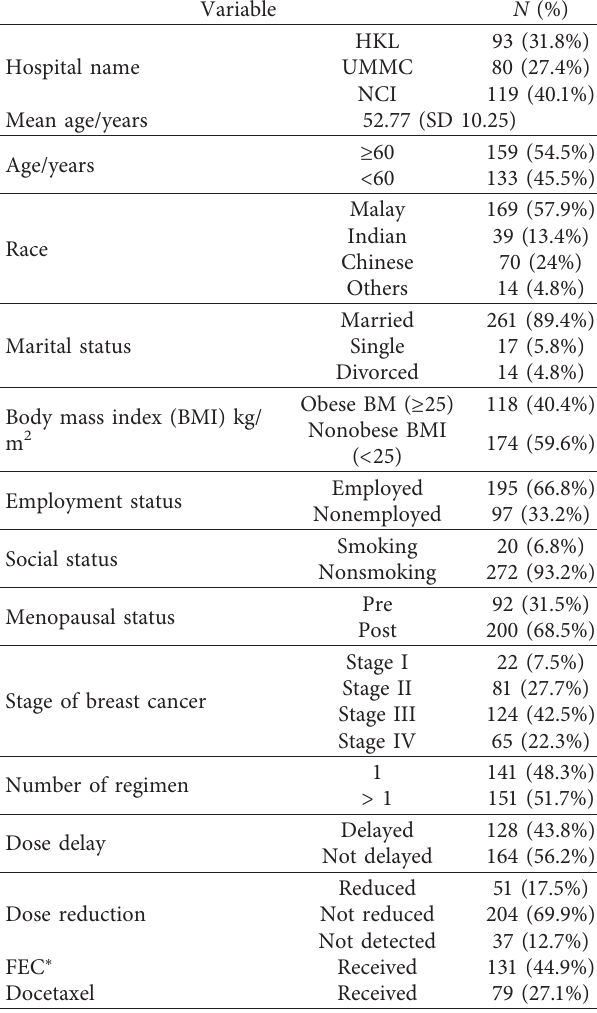
Table 1: Demographic and clinical data for the 292 patients in- cluded in the